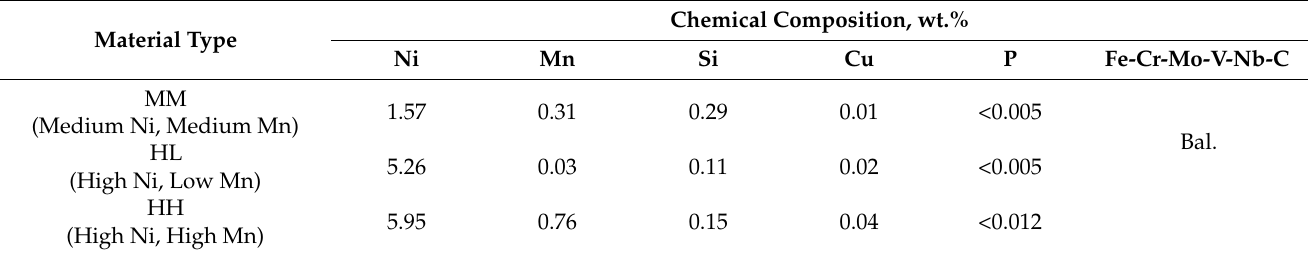
Table 1. Chemical composition of the studied